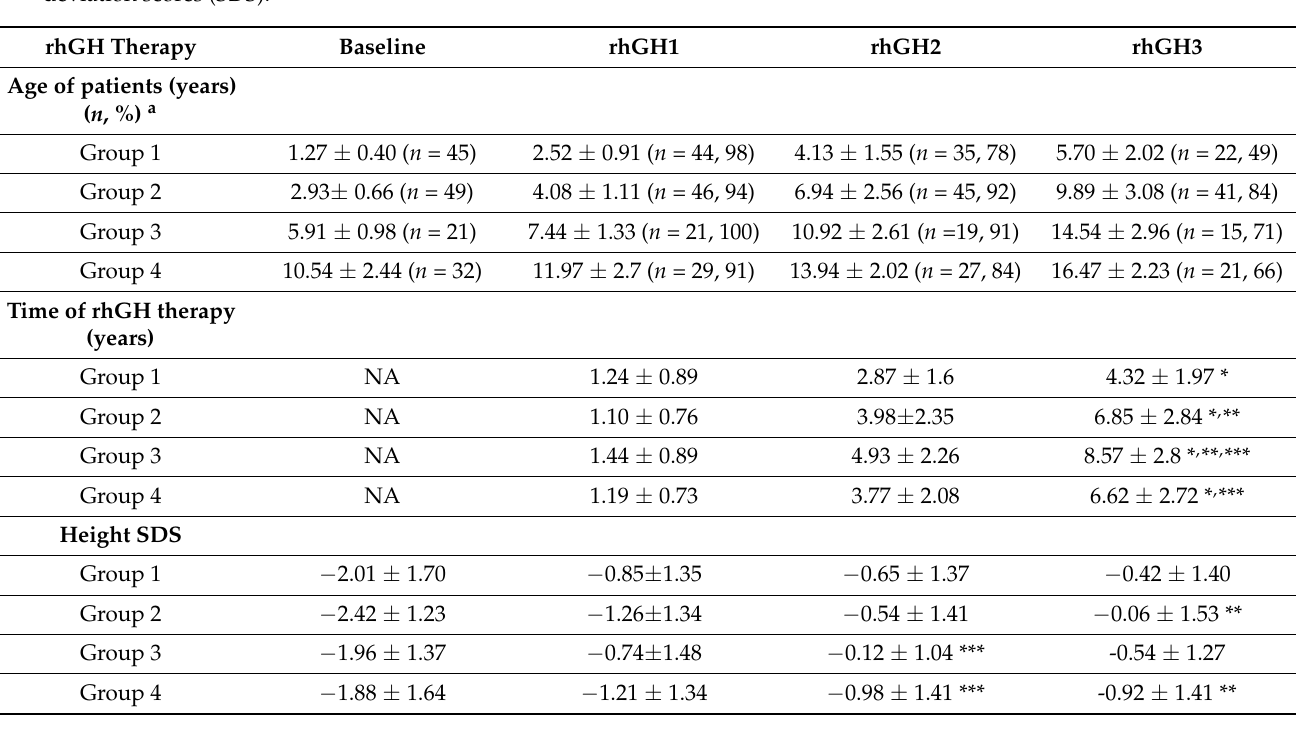
Table 3. Data during rhGH treatment in separate groups of patients with PWS, expressed as the mean value ± standard deviation scores